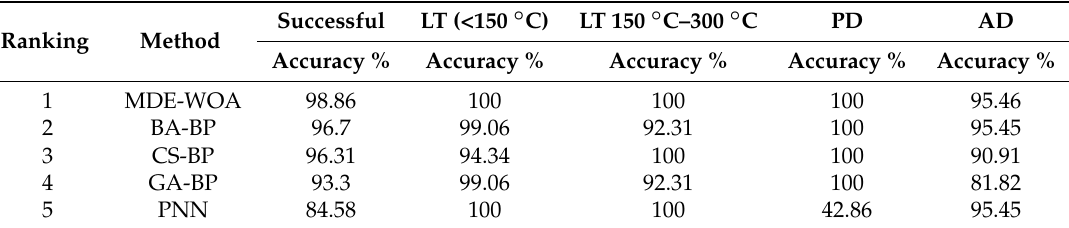
Table 3. The comparison of different